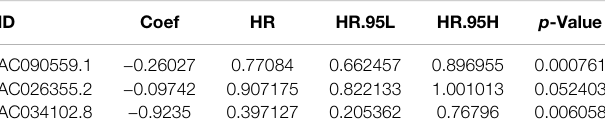
TABLE 2 | Results of multivariate Cox